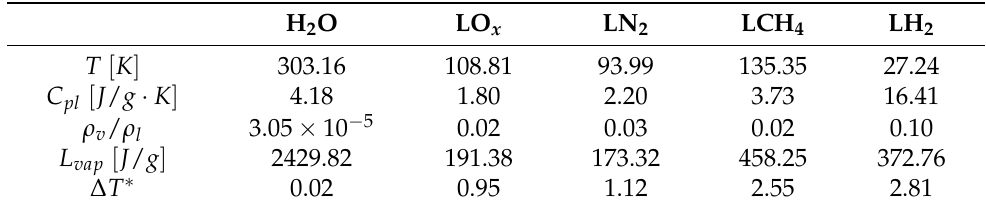
Table 1. Characteristic values for water compared to cryogenic liquids. The values are extracted from the NIST database [19].